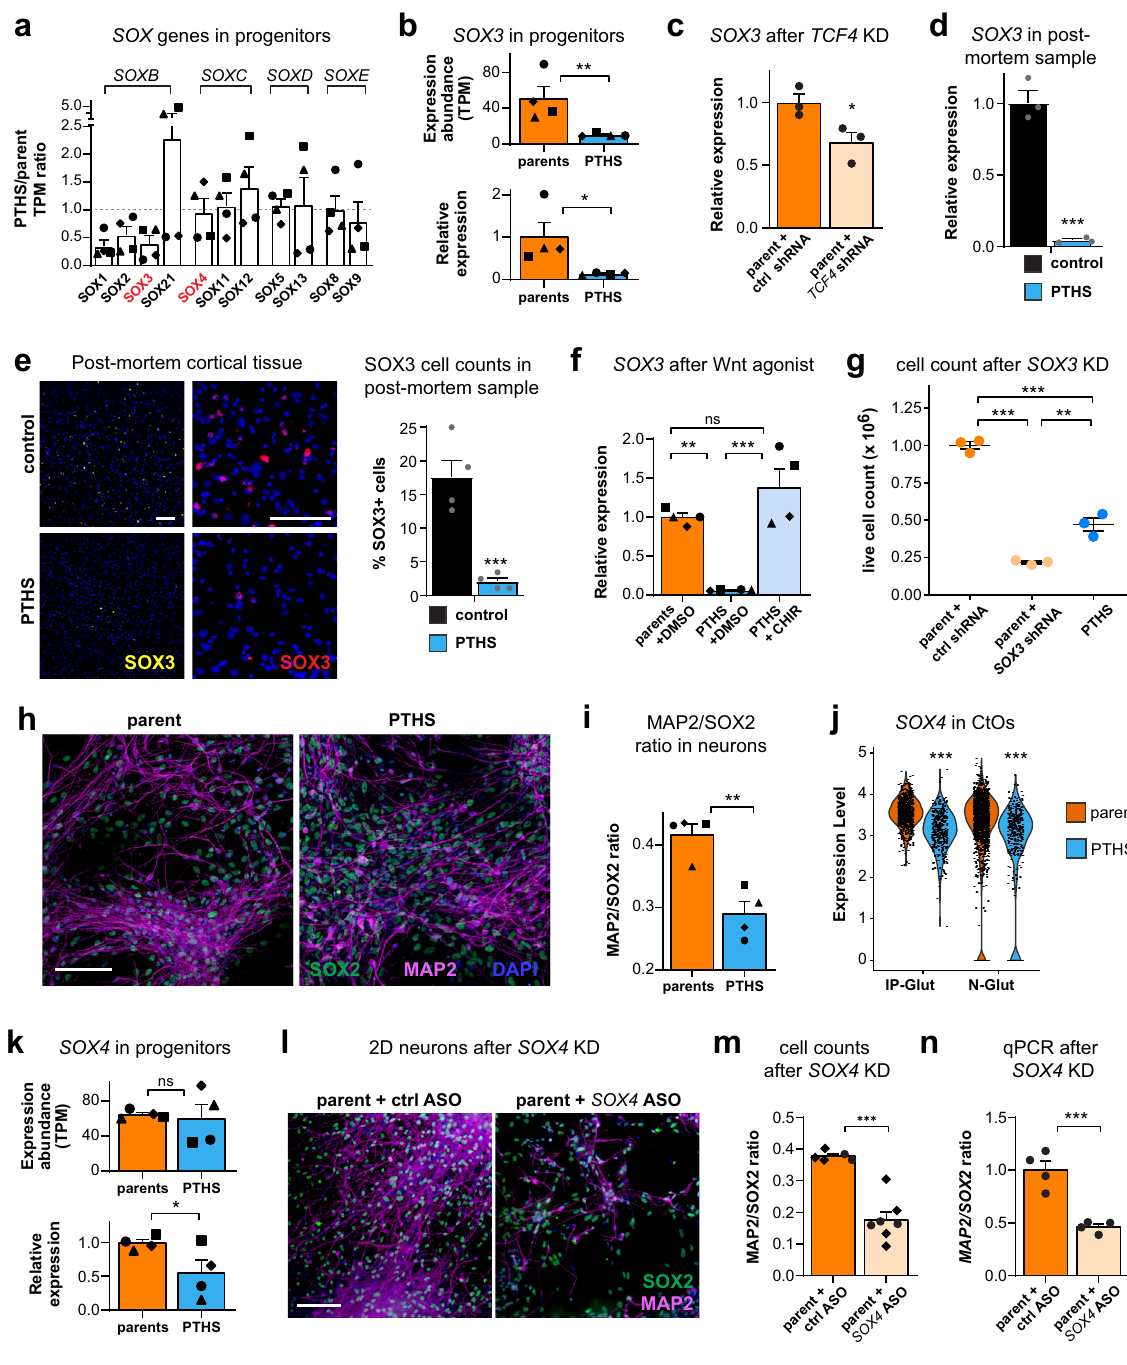
Indeed, we found that SOXC genes SOX4 , SOX11 , and SOX12 are neurons of PTHS CtOs (Fig. 7j and Supplementary Figs. 5d, 8c and expressed in intermediate progenitors and neurons of CtOs and 11g), and in GABAergic neurons of PTHS GbOs (Supplementary GbOs (Fig. 7j and Supplementary Fig. 11e – g). SOX12 was not Figs. 5d and 11e and Supplementary Data 3). Moreover, SOX4 pursued further because it is not DE in most parent-patient pairs of expression is signi fi cantly different along the differentiation NPCs in 2D culture (Supplementary Fig. 10a) and it is not DE in trajectory between parent and PTHS CtOs (Supplementary Fig. 11i). neural progenitors, intermediate progenitors, and neurons of CtOs To test the involvement of SOX4 in differentiation pathology, we (Supplementary Figs. 5d, 8c and 11g and Supplementary Data 3; see performed locked nucleic acid antisense oligonucleotide (LNA GO analysis of DE genes in intermediate progenitors in Supple- ASO)-mediated SOX4 knockdown in differentiating neuronal 2D mentary Fig. 11h). We focused on SOX4 because it was shown to be cultures from two parent lines. Both cell count and transcriptomic involved in intermediate progenitor-to-neuron differentiation 50 . analyses revealed that the differentiation rate (MAP2-to-SOX2 ratio) SOX4 expression is lower in three of the PTHS NPC lines in 2D is reduced after SOX4 knockdown (Fig. 7l – n), mimicking the culture (Fig. 7k), in progenitors, intermediate progenitors and aberrant phenotypes of PTHS neuronal cultures (Fig. 7i). NATURE COMMUNICATIONS| (2022) 13:2387